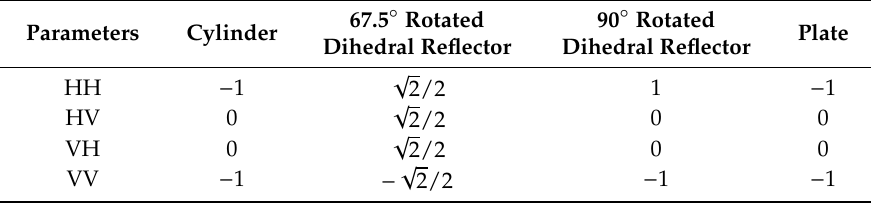
Table 3. Polarimetric scattering matrix (PSM) of four point